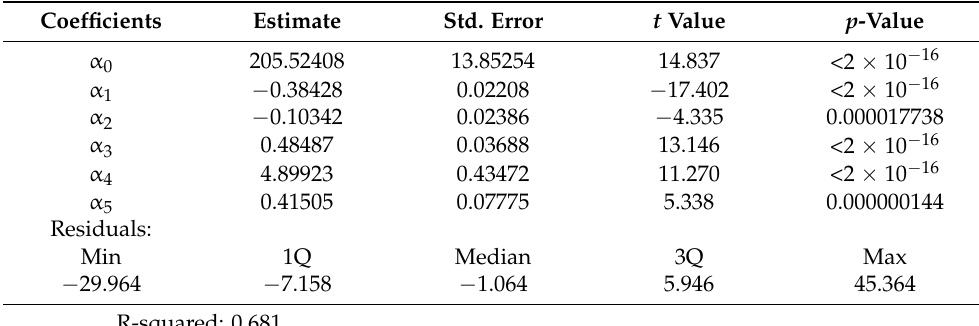
Table A1. The table contains the summary of the model described in Equation (4) adjusted to the dataset with all records.